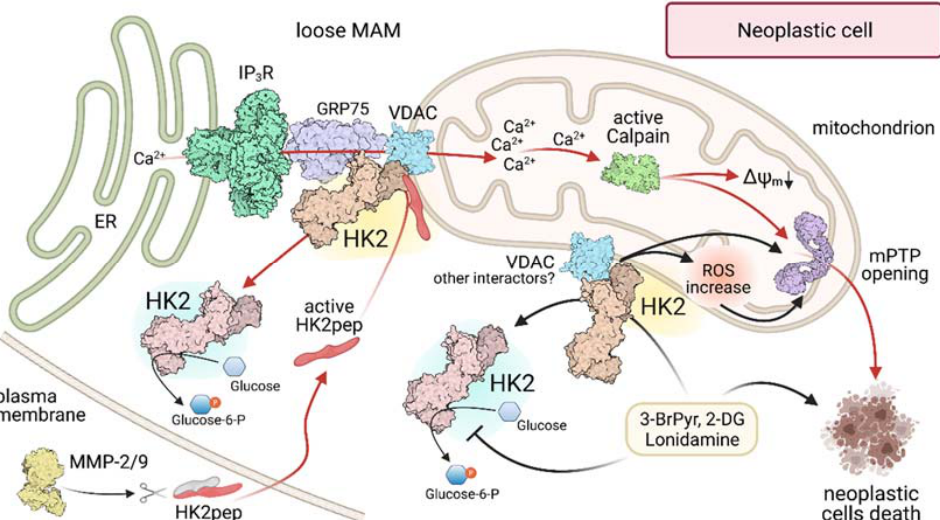
Figure 3. Modulation of HK 2 localization in MAMs of neoplastic cells. Black arrows indicate the action of 3-Br-Pyruvate (3-BrPyr), 2-DeoxyGlucose (2-DG) and Lonidamine; red arrows highlight the effects triggered by administration of a HK2-targeting peptide (HK2pep). MAM: Mitochondria-Associated Membrane; ER Endoplasmic Reticulum; IP 3 R: Inositol-3-Phosphate Receptor; GRP75: 75 kDa Glucose-Regulated Protein; VDAC: Voltage-Dependent Anion Channel; MMP-2/9: Matrix-MetalloProtease 2 or 9; ΔΨ m : mitochondrial membrane potential; mPTP: mitochondrial Permeability Transition Pore; ROS: Reactive Oxygen Species.